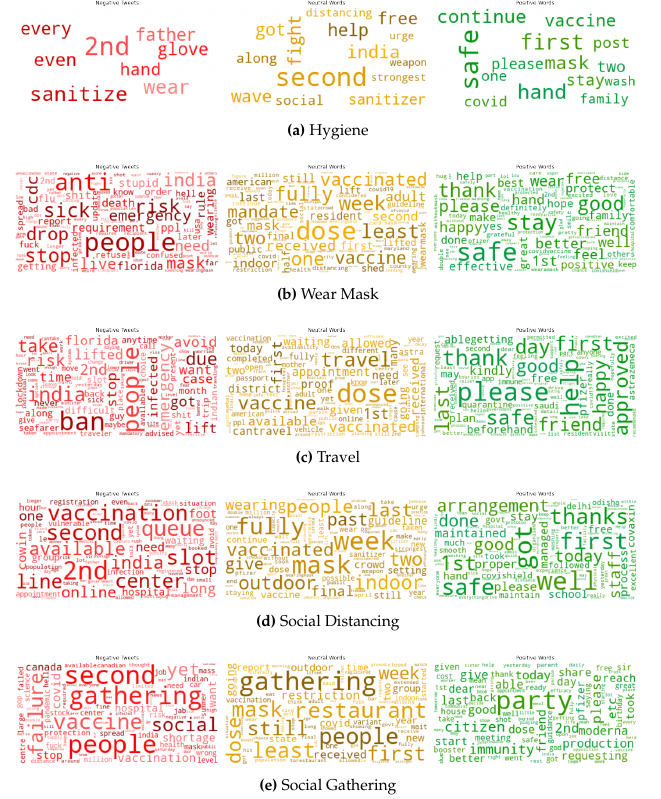
Figure 9. Top Frequency Word Distribution for Twitter Dataset 2 on Healthy Lifestyle Figure A6. Top frequency word distribution for Twitter Dataset 2 on health: word cloud generated using word